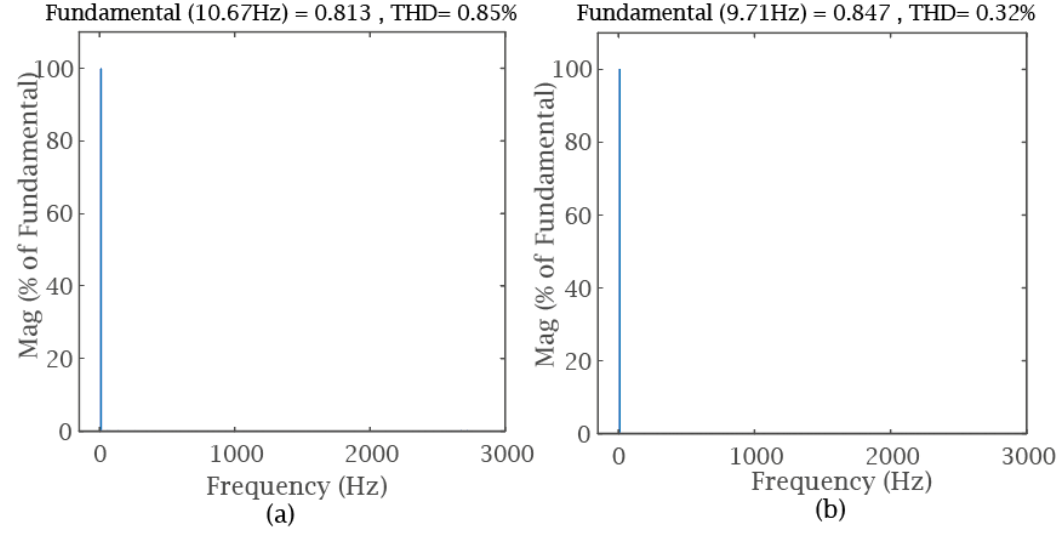
Figure 9. Rotor current harmonic spectra: ( a ) PI controller; ( b ) STA-SOSM controller.